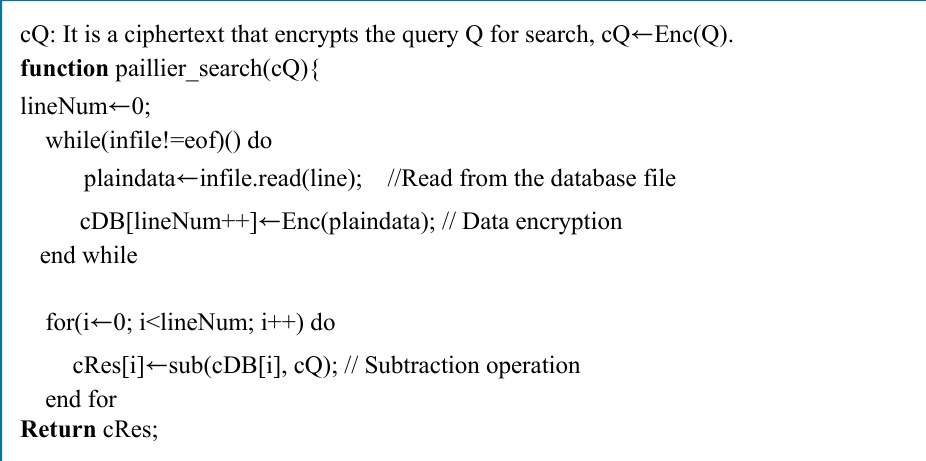
Figure 8. Pseudo code of search operation in Paillier Cryptosystem.